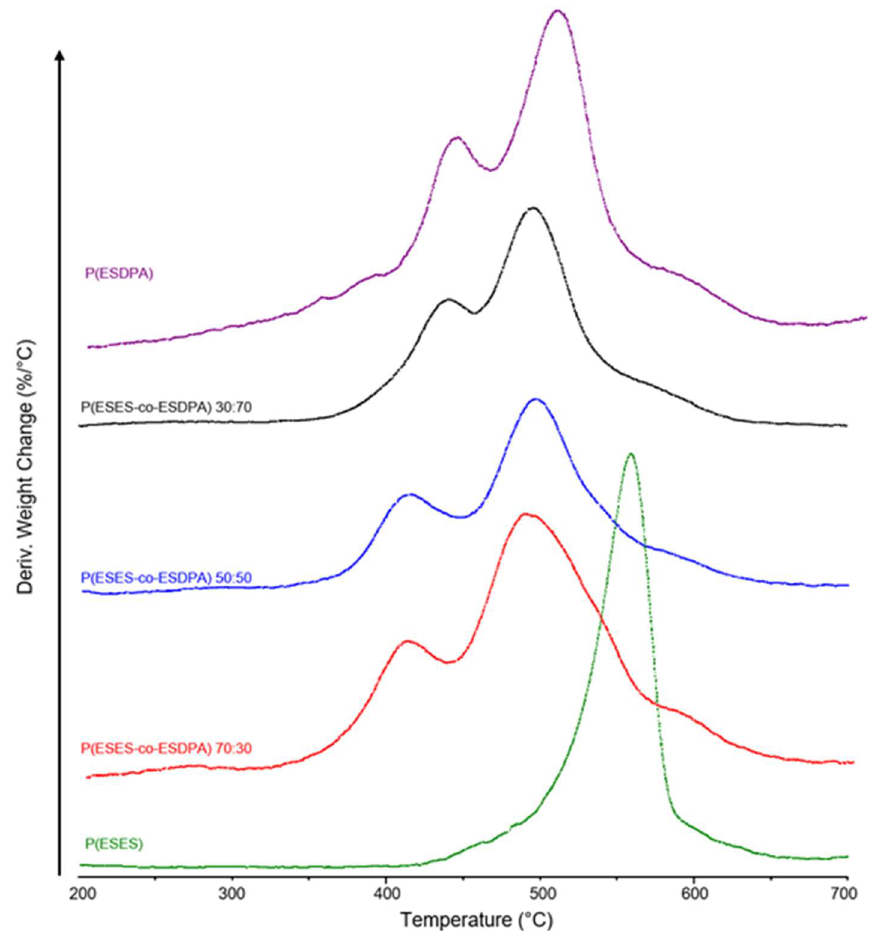
Figure 2. Differential thermogravimetric (DTG) curves of the P(ESDPA)-co-(ESES) copolymers and the corresponding homopolymers. DTG curves are shifted vertically for clarity.